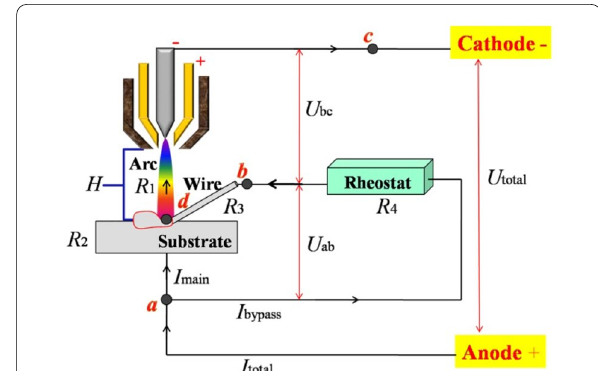
Figure 2 Relationship between voltage and current during DE-MPAW process